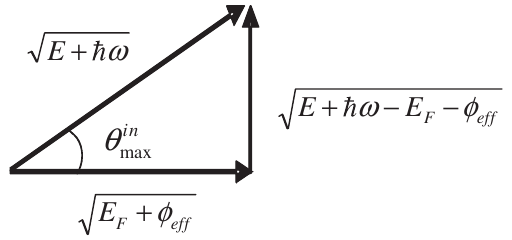
FIG. 5. (Color) Definition of the coordinate system and compo- nents of the momentum just inside the cathode surface used to derive the photoelectric